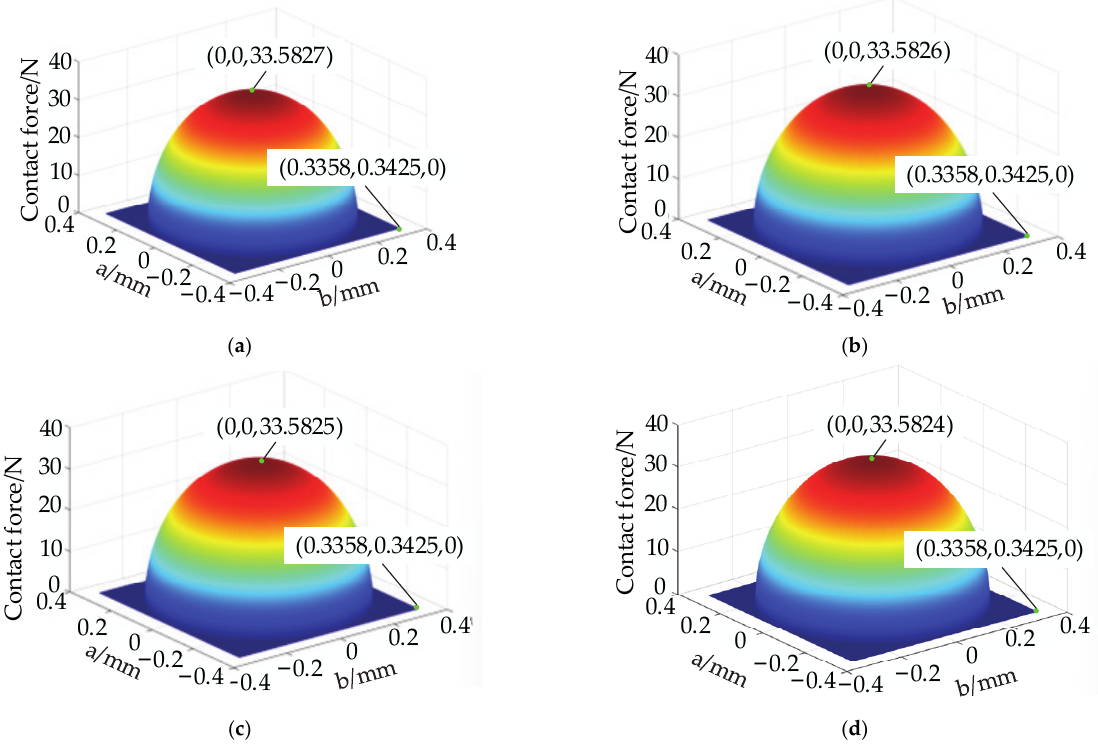
Figure 10. Internal force distribution in the contact ellipse in the non-bearing region: ( a ) rolling elements 8 and 9; ( b ) rolling elements 10 and 11; ( c ) rolling elements 12 and 13; ( d ) rolling element 14. The internal force distribution in the contact ellipse at the bearing region and at the discrete groove is shown in Figure 9. The diagram shows that as the long semiaxis a and the short semiaxis b decrease, the corresponding internal force increases. The value of the internal force corresponding to the maximum internal force is located at the center of the ellipse. Figure 9a shows the internal force distribution at the center of the discrete groove. In this position, the long and short semiaxes of the contact ellipse are the shortest due to the position where the rolling element and aggregate element overlap the smallest amount, producing the smallest internal force between the two. Figure 9b shows the force distribution within the contact ellipse corresponding to rolling elements 2 and 3. Figure 9c shows the force distribution within the contact ellipse corresponding to rolling elements 4 and 5. Figure 9d shows the force distribution in the contact ellipse corresponding to rolling elements 6 and 7. A comparison of the three diagrams reveals that the closer the rolling element is to the discrete groove, the larger the corresponding ellipse size, and its maximum internal force is also the largest, which is consistent with the internal force variation law described in Figure 8. As shown in Figure 11, the internal force distribution in the contact ellipse in the non- bearing region is the same as that in the bearing region and at the discrete groove. As the long and short semiaxes in the ellipse decrease, the internal force increases. Figure 10a shows the force distribution within the contact ellipse corresponding to rolling element 8 and rolling element 9. Figure 10b shows the force distribution within the contact ellipse corresponding to rolling element 10 and rolling element 11. Figure 10c shows the force